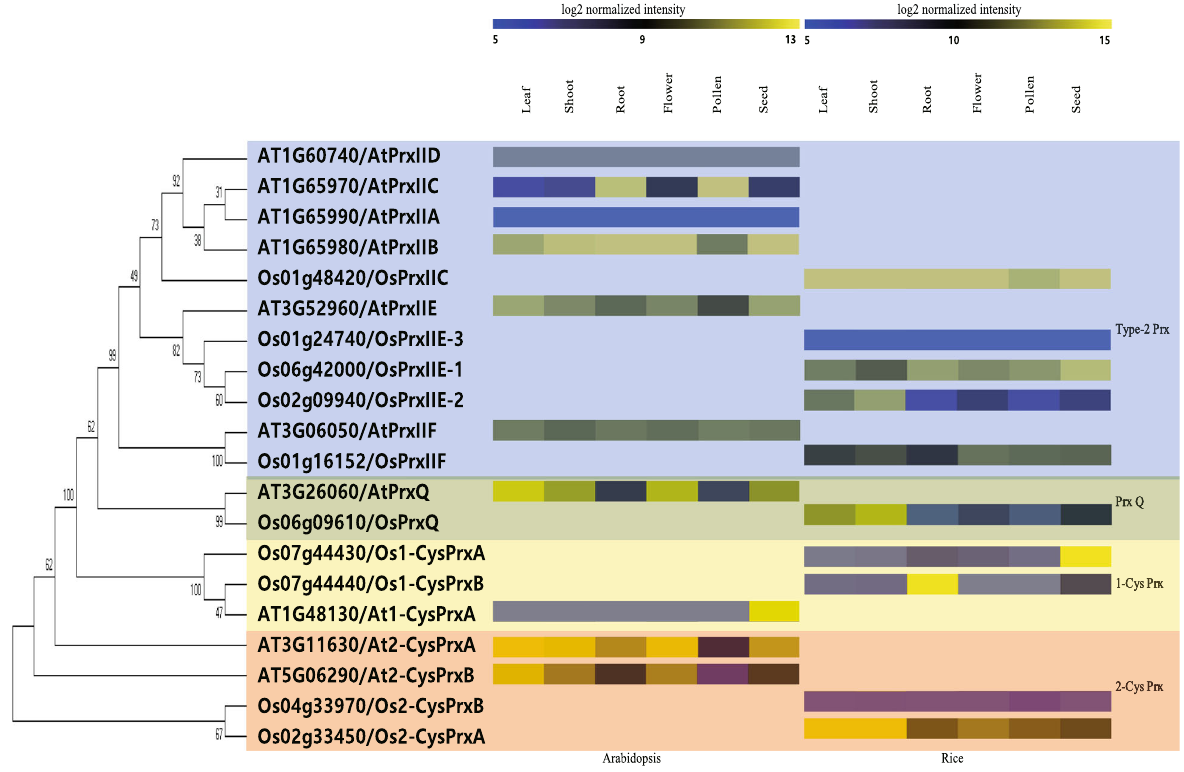
Fig. 1 Comparative meta-expression analysis of rice and Arabidopsis PRX family genes in six tissues/organs. Data from leaf, shoot, root, flower, pollen, and seed samples of both species were combined to produce phylogenetic tree. Yellow , high level of expression; blue , low level . Numeric values indicate average of normalized log 2 intensity of microarray data. Names of subgroups are on right side of heatmap. Heatmaps in middle indicate meta-expression data for Arabidopsis PRX genes on left and rice PRX genes on